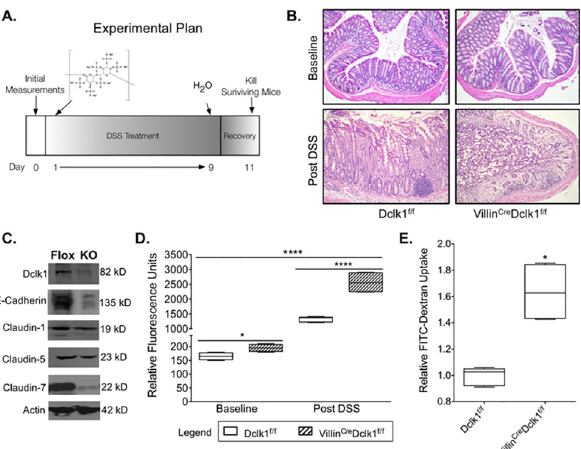
Fig 2. Deletion of Dclk1 exacerbates colonic barrier dysfunction following DSS treatment. A . Experimental plan; B . H&E staining demonstrated normal histology in Villin Cre ;Dclk1 f/f and Dclk1 f/f mice at baseline and confirmed a significant inflammatory response following DSS treatment (200x magnification) C . Western blot analysis of tight junction and adherens junction proteins demonstrated a decrease in Claudin-1, Claudin-7, and E-cadherin in the Villin Cre ;Dclk1 f/f mice after DSS treatment; D. FITC-Dextran levels in the serum of each mouse were determined 4 h after gavage in baseline and post DSS treatment (n = 5 for